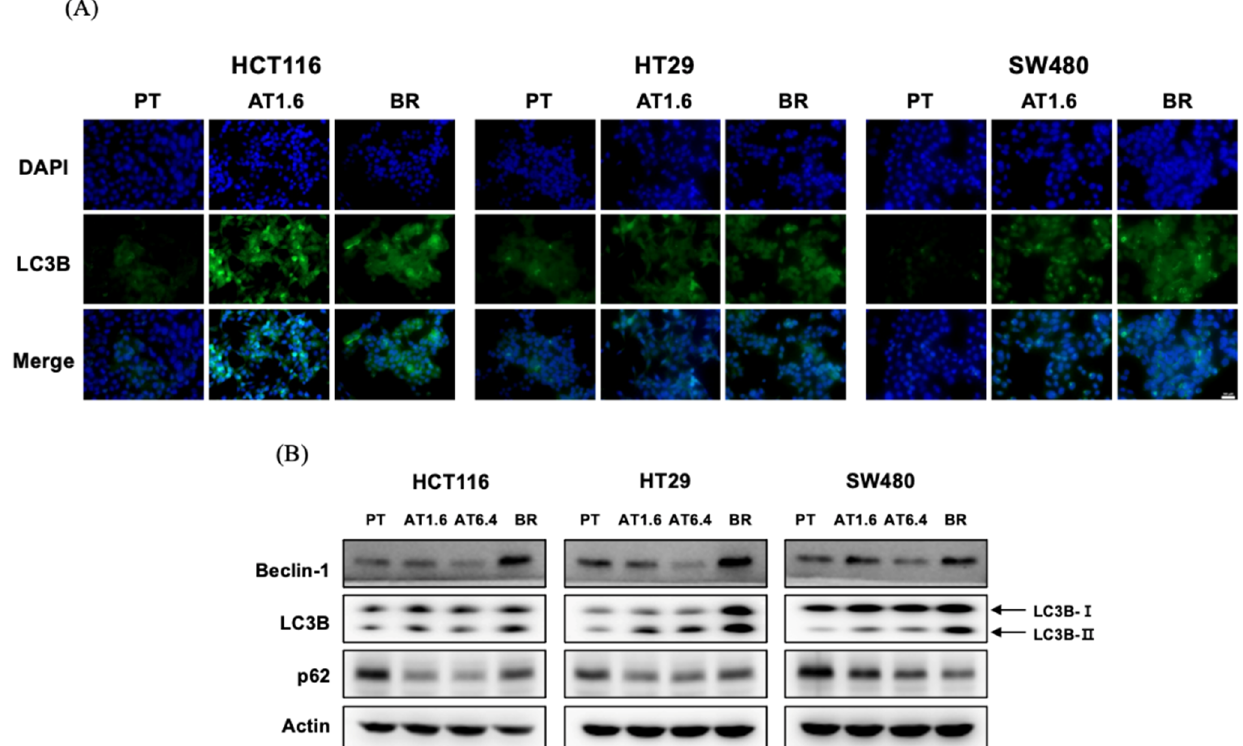
Figure 4. Effects of butyrate resistance on the induction of autophagy in parental (PT), 1.6 and/or 6.4 mM sodium butyrate- treated PT for 24 h (AT1.6 and/or AT6.4), and butyrate-resistant (BR) colon cancer cells of HCT116, HT29, and SW480. ( A ) Fluorescence was visualized by confocal microscopy. LC3B protein was labeled green (Alexa 488), and the nucleus was stained with DAPI. The size of scale bar was 100 μm. ( B ) Protein expression of Beclin-1, LC3B, and p62 was determined by immunoblot analysis. Actin was used as an internal control. This was repeated in three independent experiments.